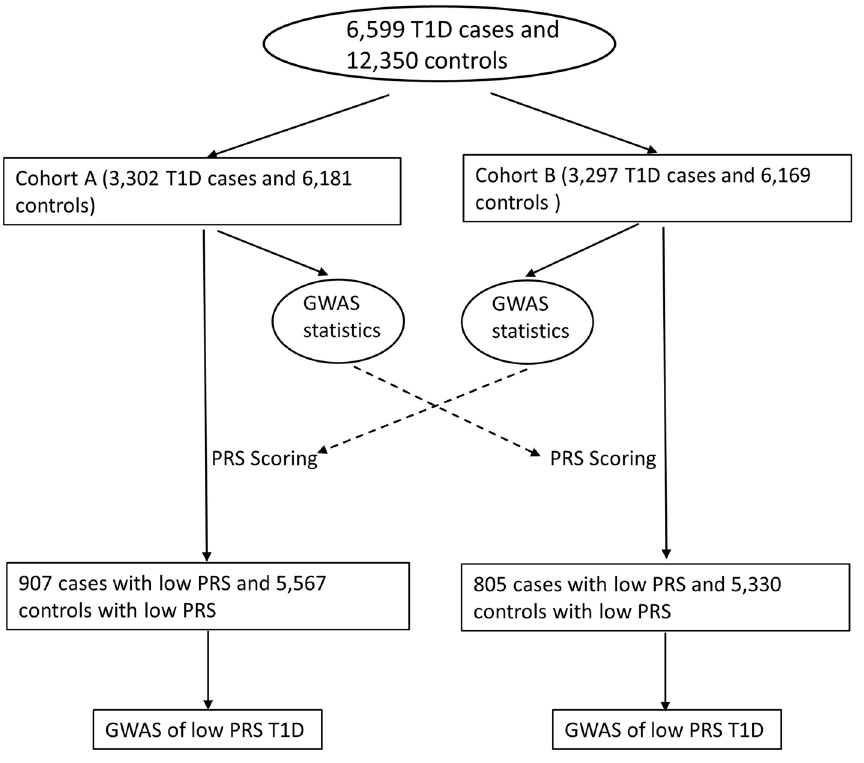
Figure 1. The flow chart of the study